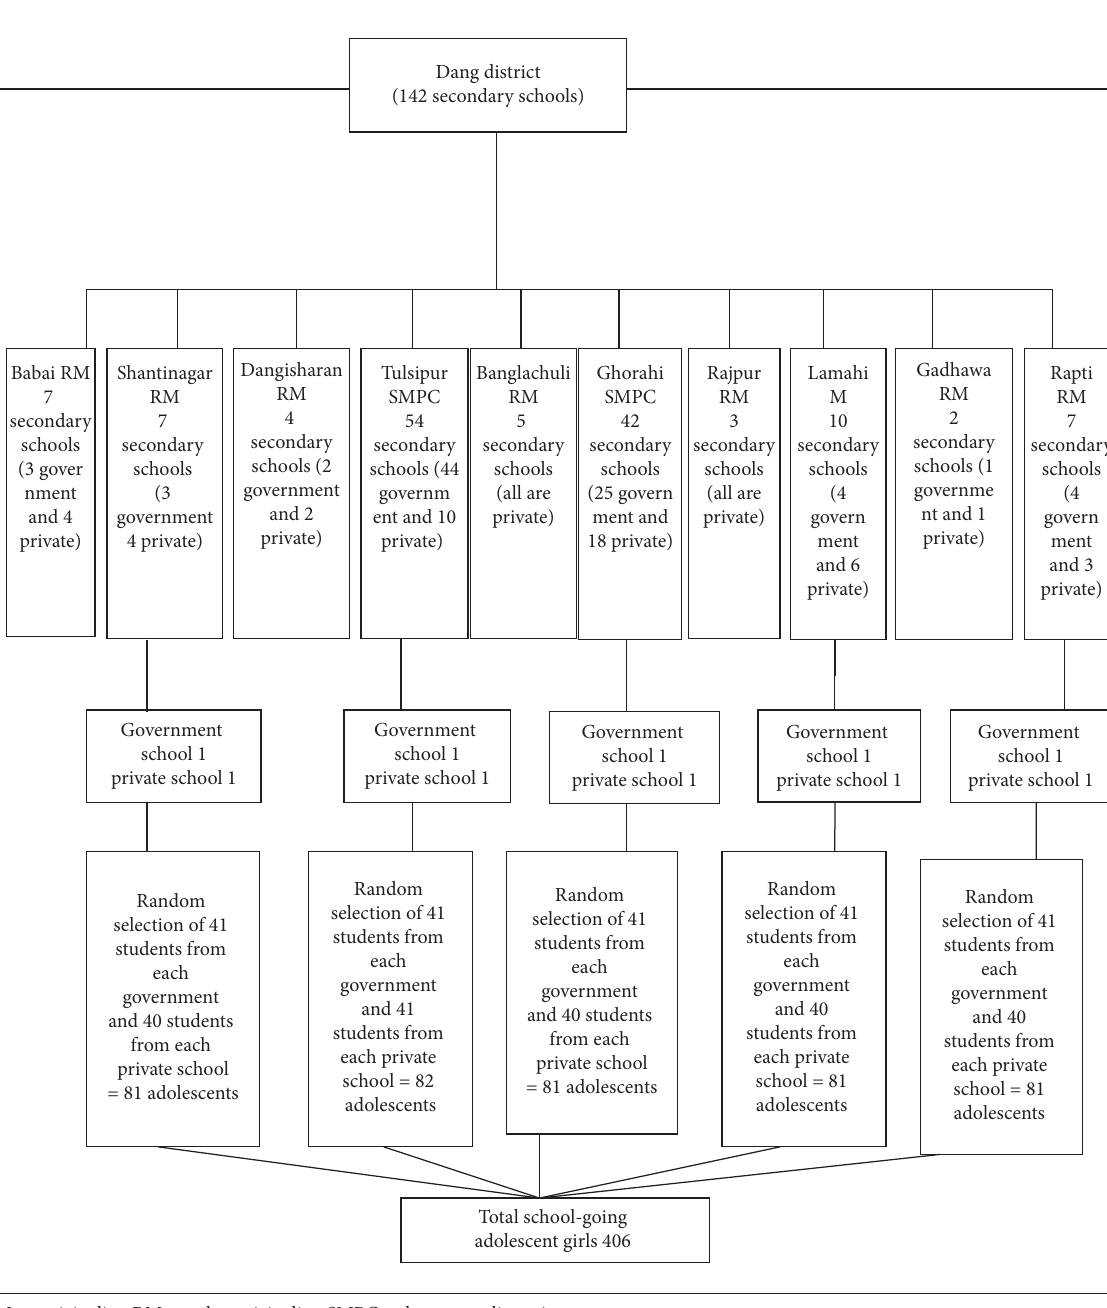
Figure 1: Multistage stratified probability random sampling